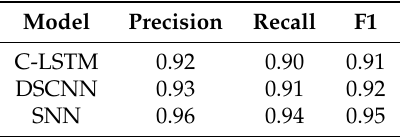
Table 3. Question type classification results.